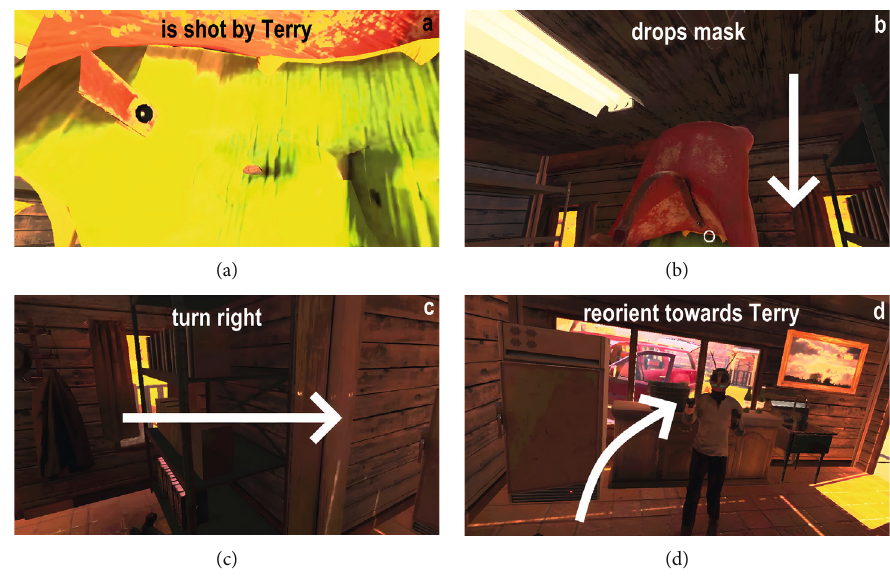
Figure 8: Establishment of participation